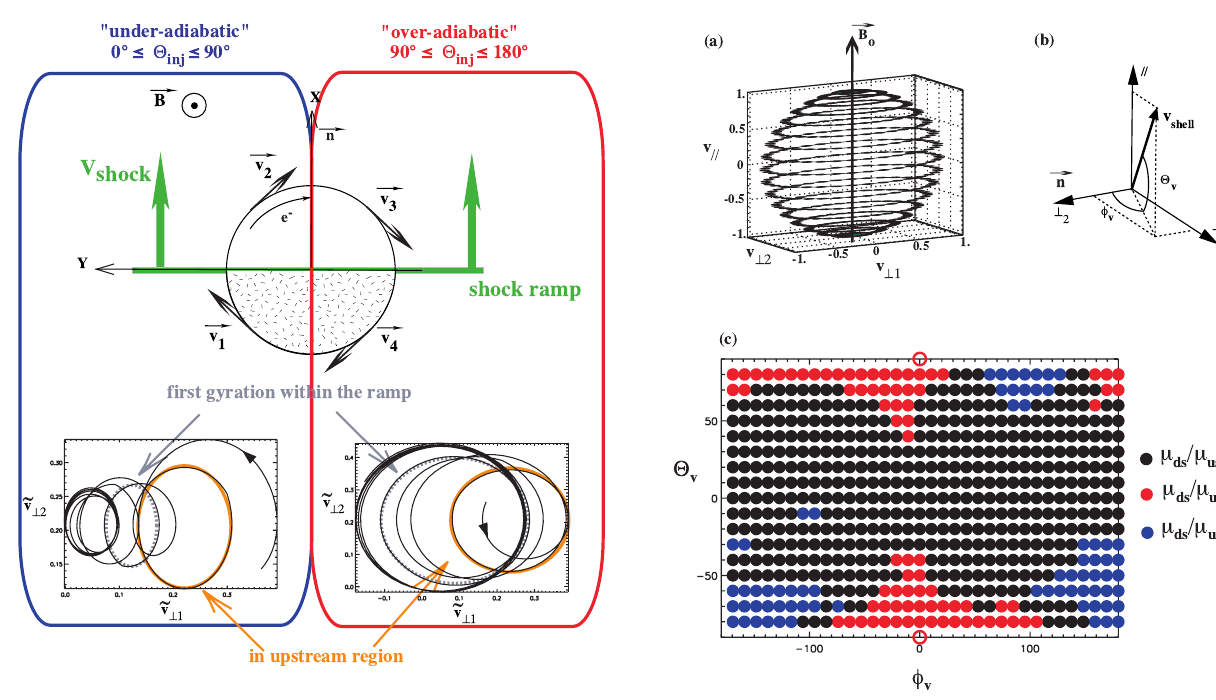
Fig. 7. (a) A spherical shell of 580 electrons (test particles) is located at b x = 200 4 , upstream from the front of the moving su- percritical collisionless shock. The shell is aligned along the up- stream magnetic field ( B o ), (b) reference frame used for the spher- ical shell (radius v shell ), (c) initial upstream location ( θ v , φ v ) of electrons versus their final state in the downstream region. This downstream state is indicated by the color code identifying the adi- abatic (black), “under-” (blue) and “over-adiabatic” (red) electrons, as used in Fig. 1. We compute the mean value of µ in the down- stream region over lots of gyrations, from the overshoot to the end of the